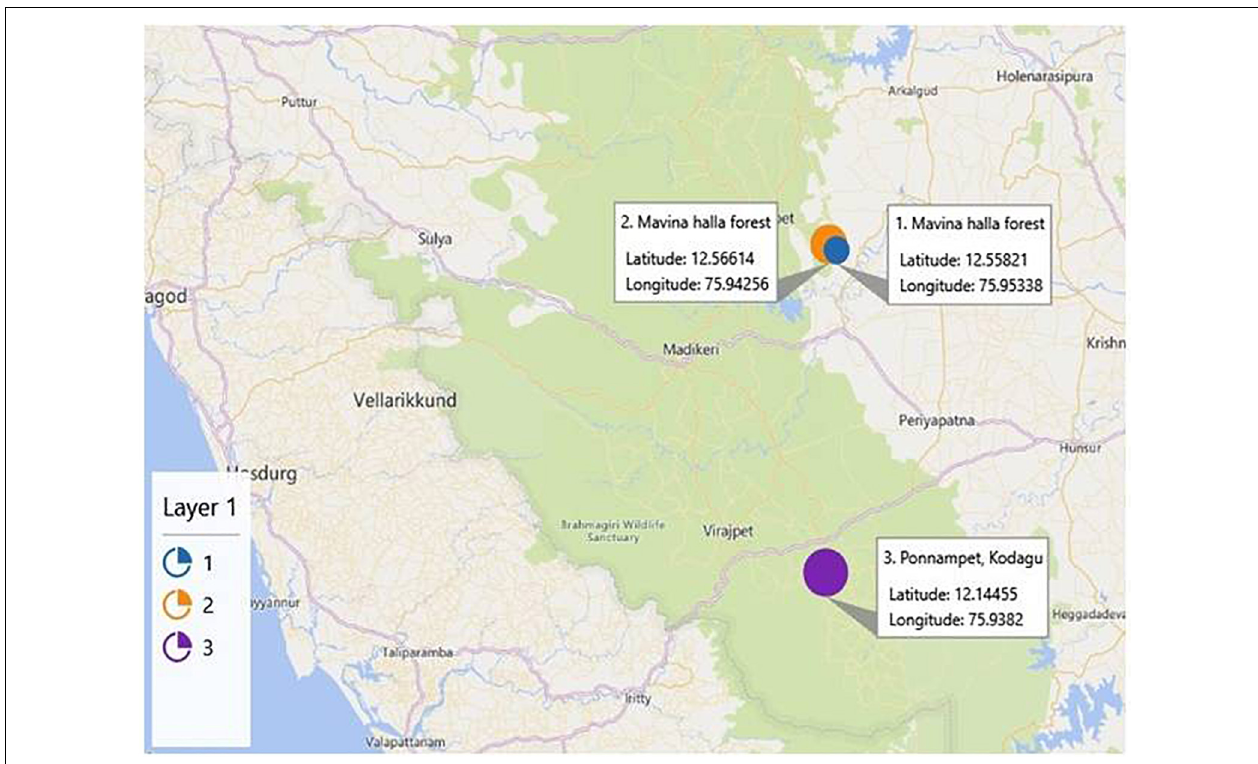
FIGURE 1 | Representation of the geographical location of sampling sites, namely, Mavina Halla forest (1 and 2) and Ponnampet (3), of Kodagu district located in the Western Ghats forest of India (courtesy: Google maps).